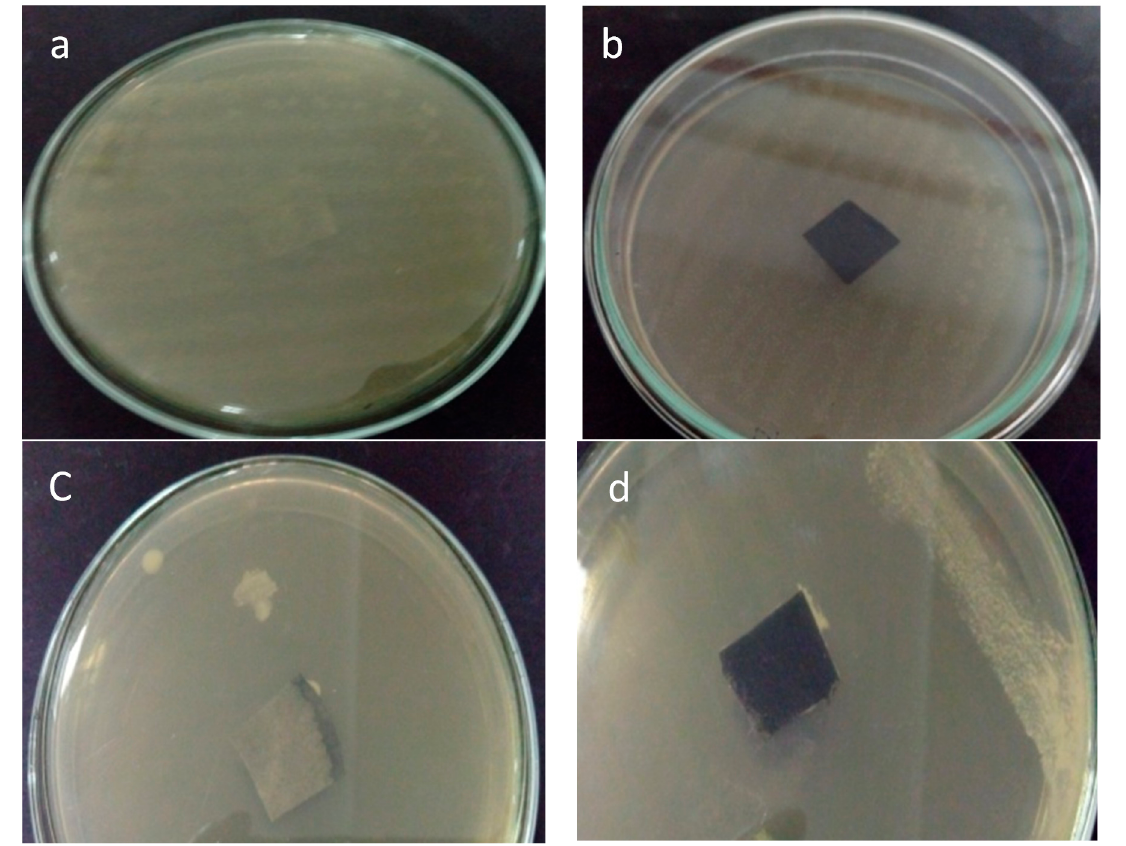
Figure 9. Photos of surfaces of hardened filter paper ( a , c ) and CNF/AC membrane ( b , d ) subjected to S. aureus and E. coli inoculums, respectively.